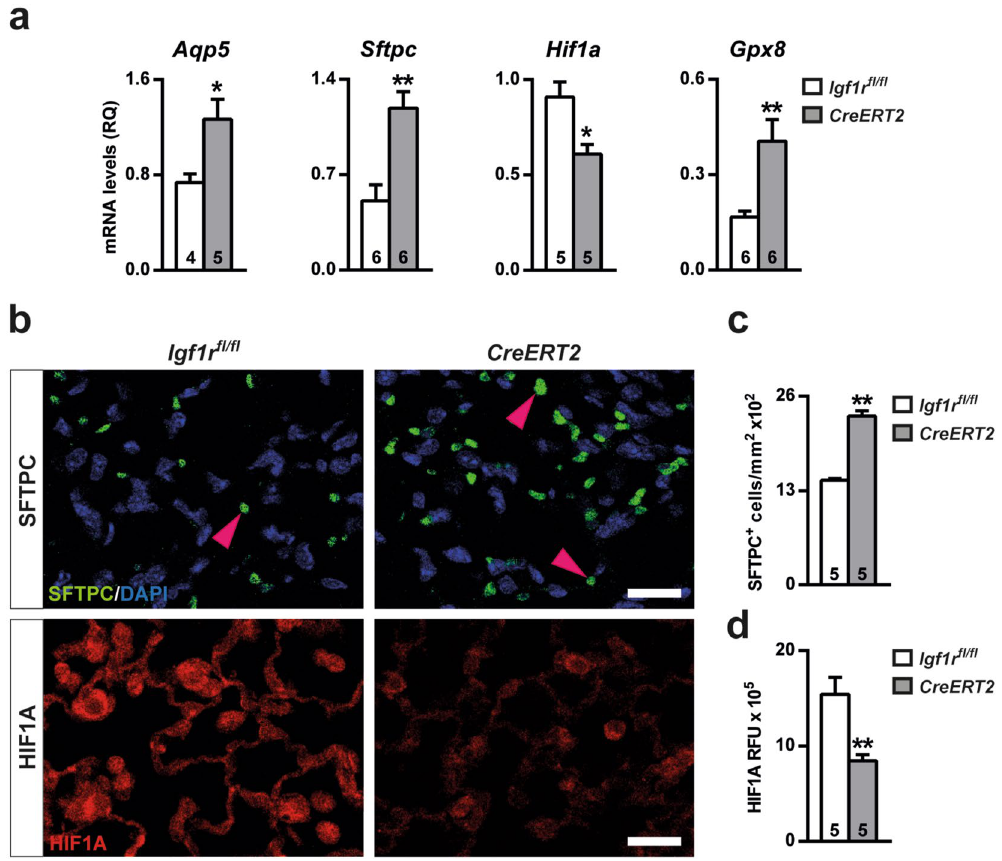
Figure 8. Reduced alveolar damage and HIFA expression in BLM-challenged lungs of IGF1R-deficient mice. ( a ) Changes in mRNA expression of alveolar ( Aqp5 and Sftpc ), response to hypoxia ( Hif1a ), and antioxidative stress ( Gpx8 ) markers, ( b ) representative SFTPC (pink arrowheads) and HIF1A immunostained sections (upper and bottom panels, respectively), ( c ) number of SFTPC positive cells per unit area of lung tissue, and ( d ) quantification of HIF1A relative fluorescence intensity in lungs of UBC-CreERT2 ; Igf1r fl / fl ( CreERT2 ) and Igf1r fl / fl mice at D3 after BLM treatment. Scale bars: 20 µ m. Numbers within graphic bars indicate the number of mice analyzed and data are expressed as mean ± SEM. * p < 0.05; ** p < 0.01 (Mann-Whitney U test). RFU, relative fluorescence